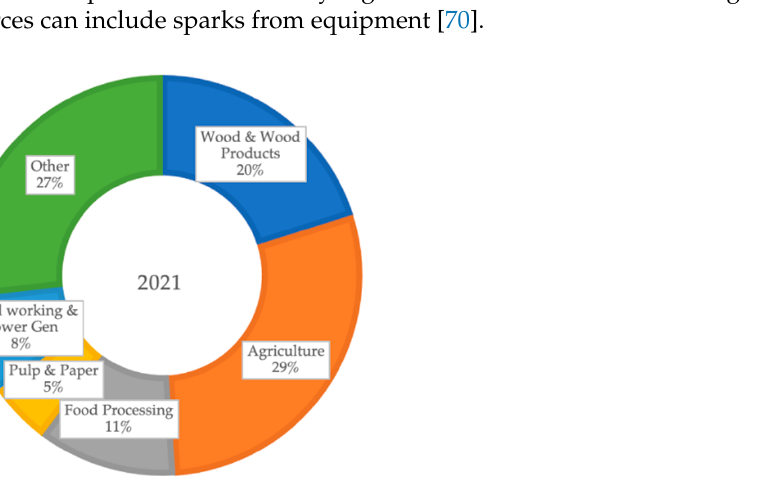
limits. The minimum explosive concentration (MEC) is the smaller concentration at which